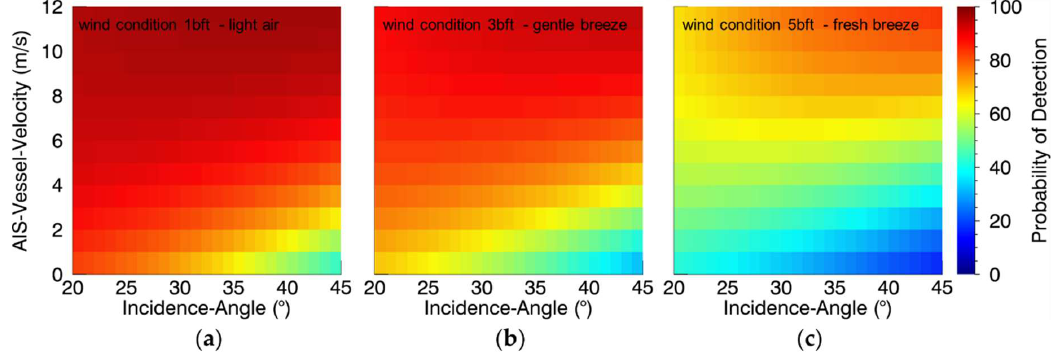
Figure 8. 2D detectability charts based on Incidence-Angle, AIS-Vessel-Velocity and from left to right Beaufort numbers with: ( a ) 1 bft, ( b ) 3 bft, and ( c ) 5 bft. Beaufort numbers with: ( a ) 1 bft, ( b ) 3 bft, and ( c ) 5